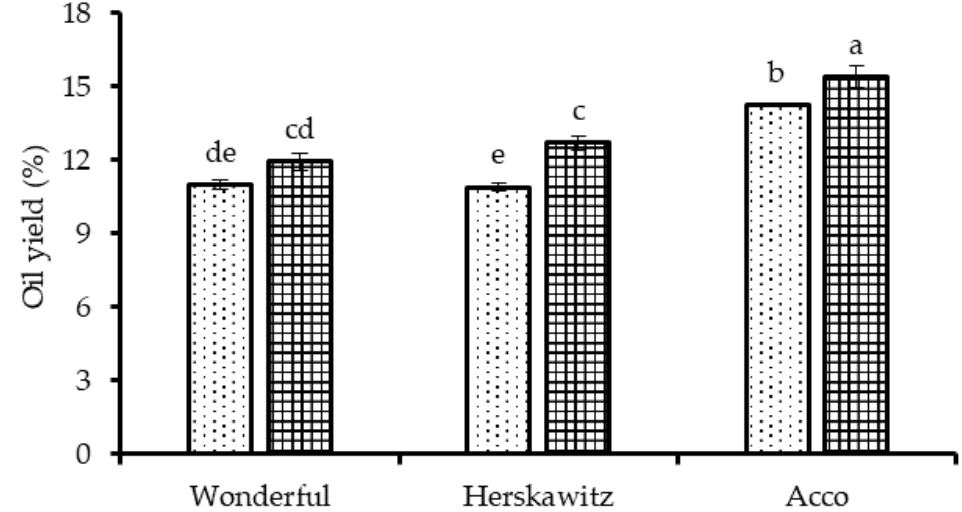
Figure 1. Oil yield from un-pretreated and enzyme pretreated seeds (1.7%, 40 °C, pH = 4.5 and 5 h) of three pomegranate cultivars. Within the same cultivar (un-pretreated and enzyme pretreated), columns followed by different letters are significantly different ( p < 0.05) according to Duncan’s multiple range test. Vertical bars indicate the standard deviation of the mean.